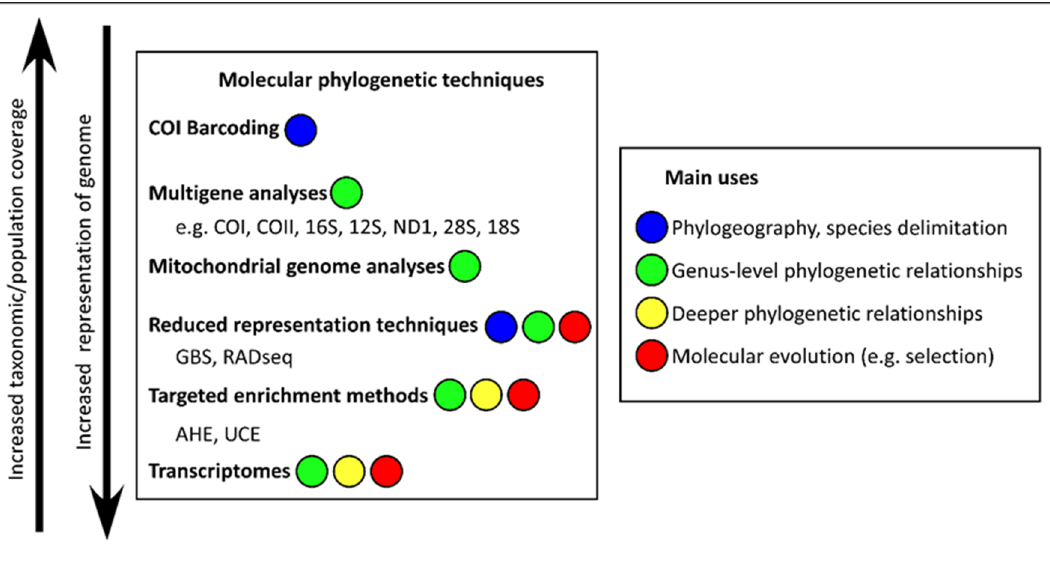
Figure 1. Main molecular phylogenetic techniques available for earthworm systematics and evolu- tionary research.